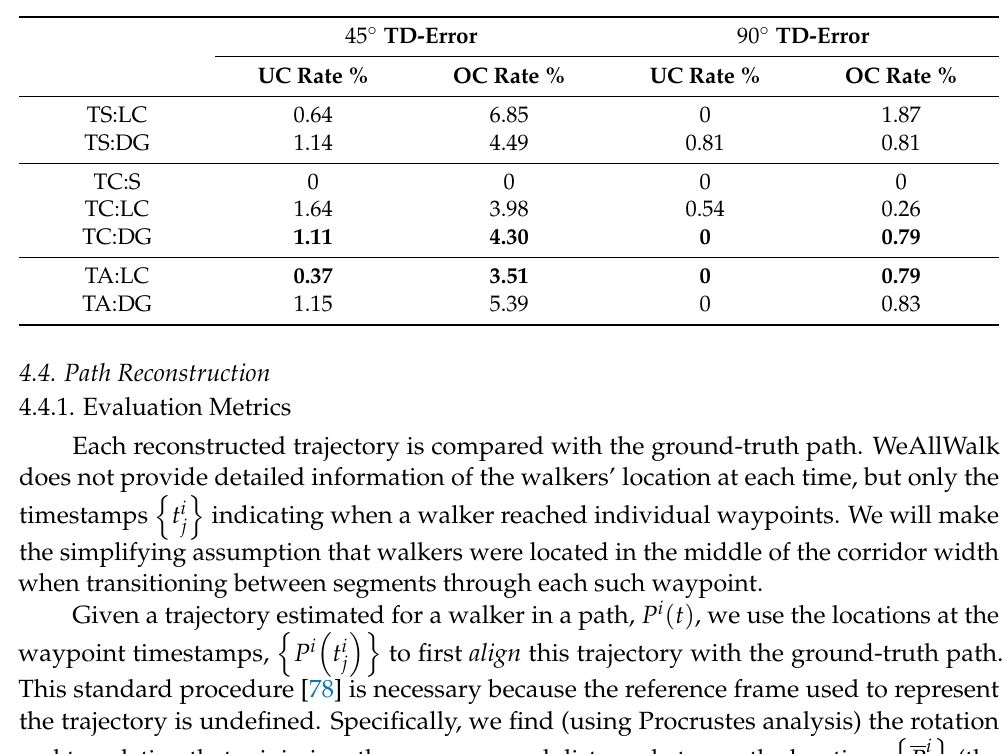
Table 2. Undercount (UC) and overcount (OC) rates for our turn detector (45 ◦ and 90 ◦ turns). For each community of blind walkers (LC, DG), the pair (UC rate, OC rate) with the smallest value of their sum is shown in